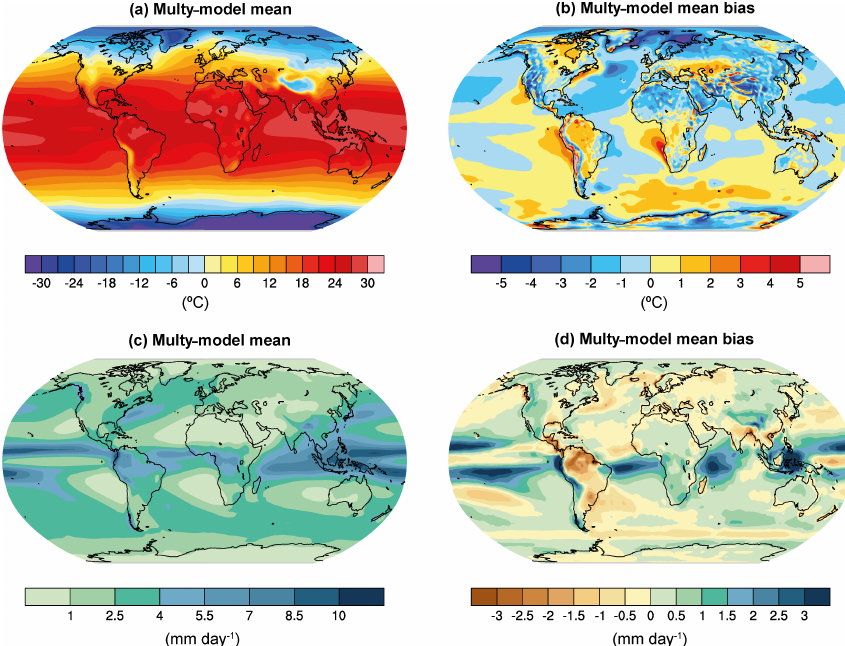
Figure 4. Annual-mean surface air temperature (upper row) and precipitation rate (mmday − 1 , lower row) for the period 1980–2005. The left panels show the multi-model mean and the right panels the bias as the difference between the CMIP5 multi-model mean and the climatology from ERA-Interim (Dee et al., 2011) and the Global Precipitation Climatology Project (Adler et al., 2003) for surface air temperature and precipitation rate, respectively. The multi-model mean near-surface temperature agrees with ERA-Interim mostly within ± 2 ◦ C. Larger biases can be seen in regions with sharp gradients in temperature, for example in areas with high topography such as the Himalaya, the sea ice edge in the North Atlantic, and over the coastal upwelling regions in the subtropical oceans. Biases in the simulated multi-model mean precipitation include too low precipitation along the Equator in the western Pacific and too high precipitation amounts in the tropics south of the Equator. Similar to Figs. 9.2 and 9.4 of Flato et al. (2013) and produced with namelist_flato13ipcc.xml